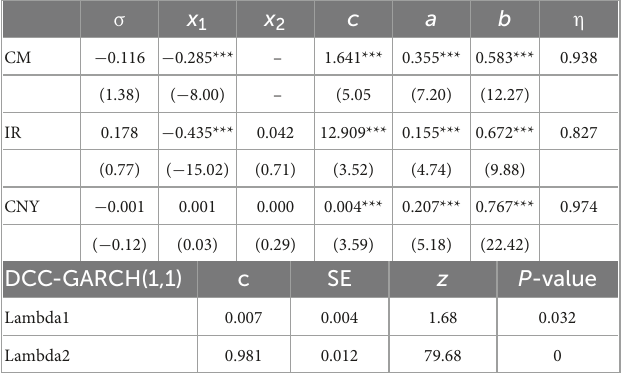
η is calculated from the sum of the ARCH and GARCH term coefficients (a+b). Mean value equation:r t = ó + x 1 r t − 1 + x 2 r CM t − 1 +∈ t